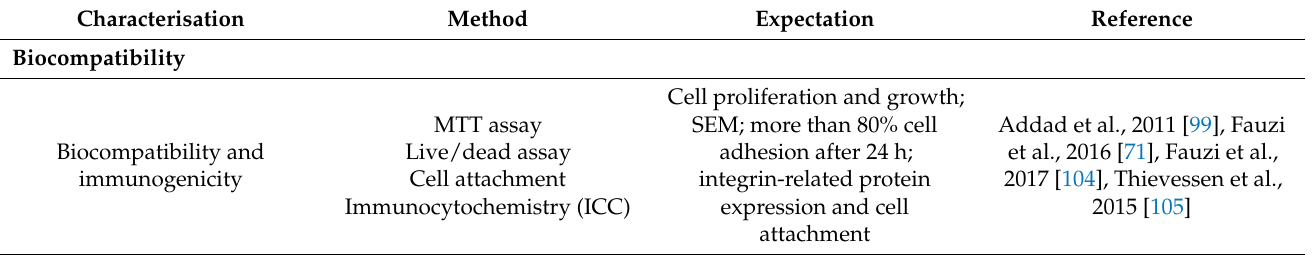
Table 2. Collagen type I physicochemical characterisation methods and expected